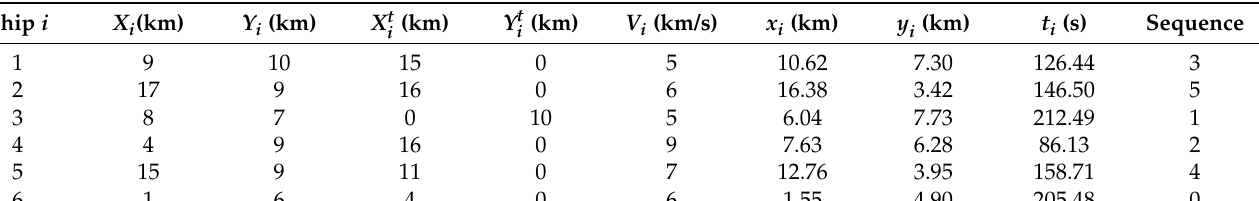
Table 4. Demonstrate the results of case-solving.